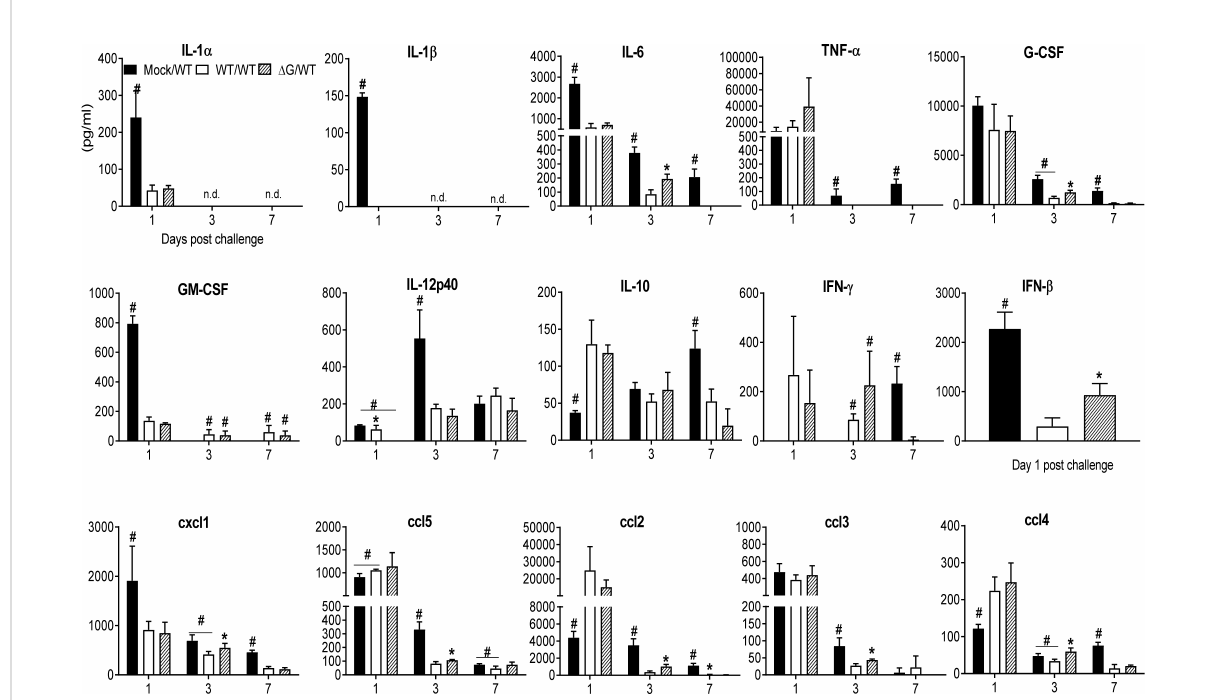
FIGURE 8 BAL fl uid levels of pro-in fl ammatory cytokines, chemokines and type I IFNs in response to virus challenge. Mock and previously rhMPV-WT or - D G infected mice were challenged with rhMPV-WT virus as previously described in Material and Methods. Levels of cytokines and chemokines in BAL fl uid were measured by Bio-Plex. Levels of IFN- b were measured by ELISA. Data are expressed as mean ± SEM of four to six animals/ group and is representative of one of three independent experiments. *P<0.05 when comparing rhMPV -WT and - D G mice challenged with rhMPV -WT.; # P<0.05 when comparing rhMPV (-WT and - D G) challenged with rhMPV -WT and mock- mice challenged with rhMPV -WT. Mock/ rhMPV -WT = Mock/WT; rhMPV - D G/rhMPV – WT = D G/WT; rhMPV -WT/rhMPV -WT = WT/WT. n.d., not